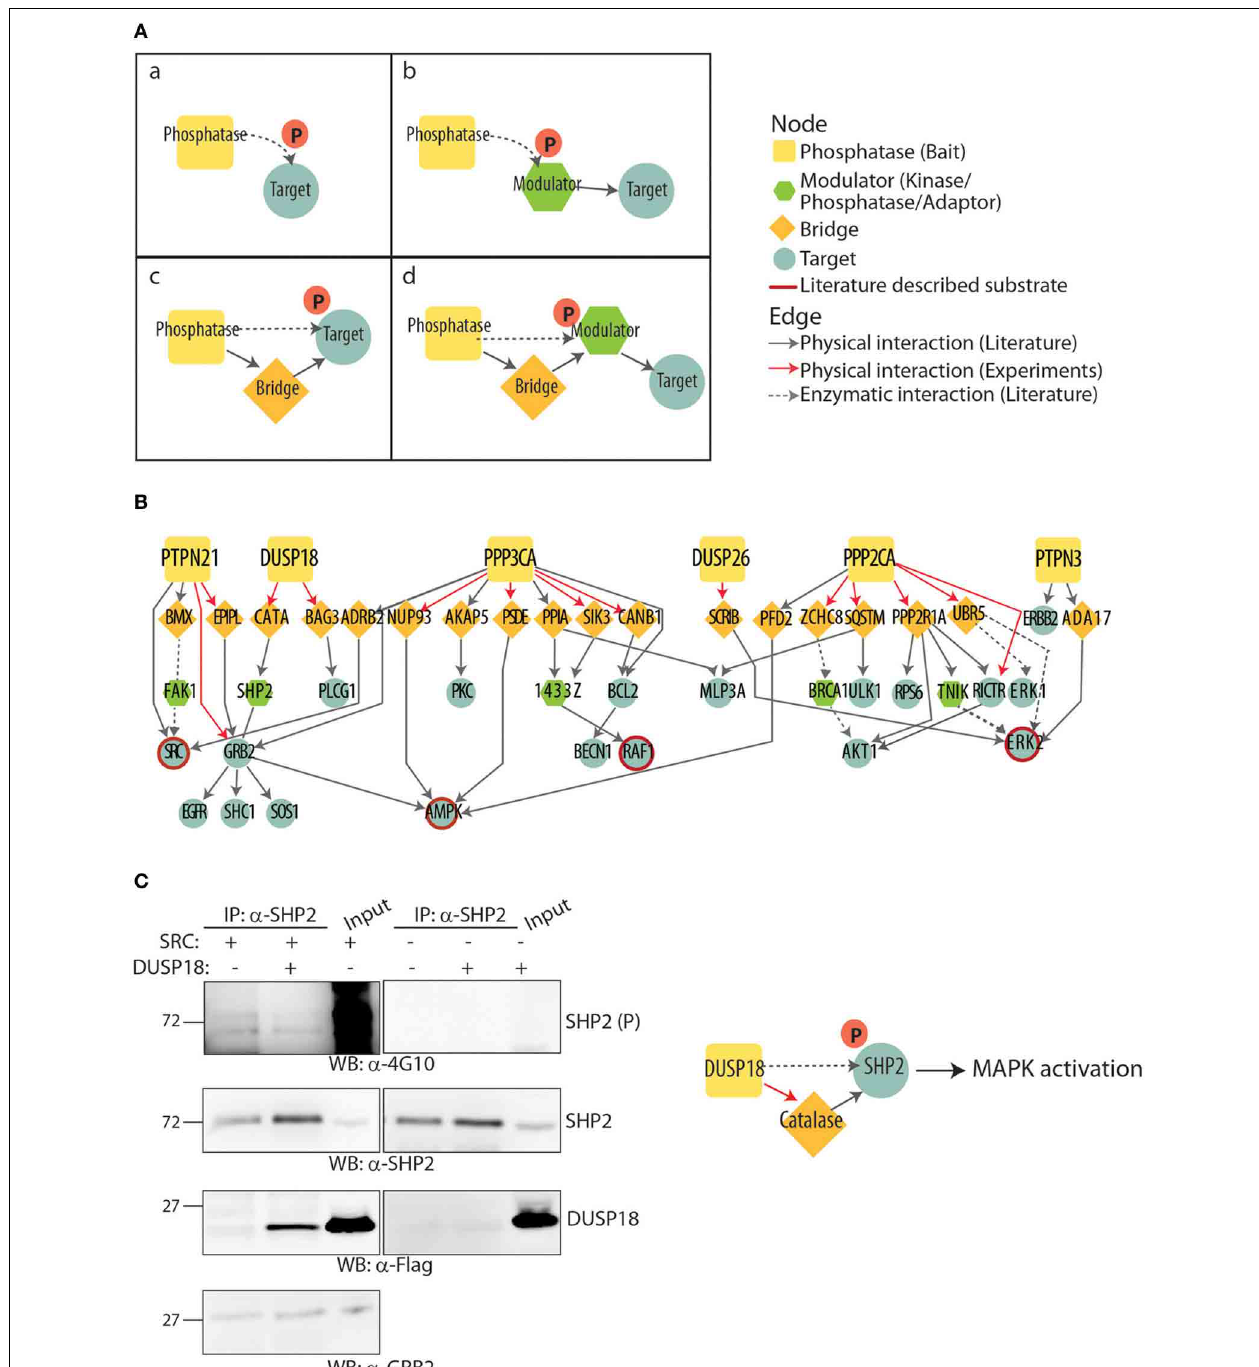
FIGURE 6 | Inferring new phosphatase substrates. (A) Schematic representation of the multiple paths going from phosphatase to substrates. (B) The multiple paths going from phosphatases to substrates are represented as a graph. Nodes have different shapes according to their functional role: phosphatases are indicated as squares, bridge proteins as diamonds, modulators as hexagons and inferred substrate as circles. The red border outlines phosphatase substrates that have been already reported in literature. Solid black and red lines indicate physical interaction literature and experimentally supported, respectively, while black dashed line represent